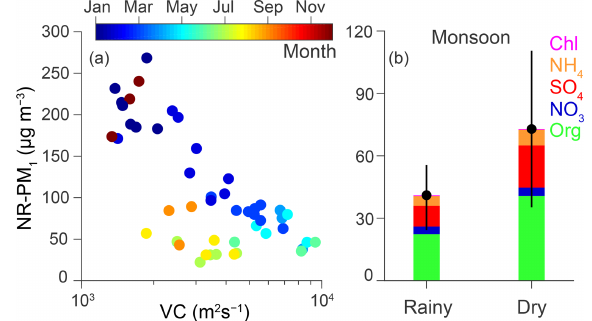
Figure 6. (a) Variations of NR-PM 1 mass concentrations as a func- tion of ventilation coefficient. Each scatter point is a weekly average and is color coded by month. Note that July to mid-September is the monsoon season. (b) Average NR-PM 1 composition for days with (rainy) and without rain (dry). The vertical lines are the 25th (bot- tom) and 75th (top)